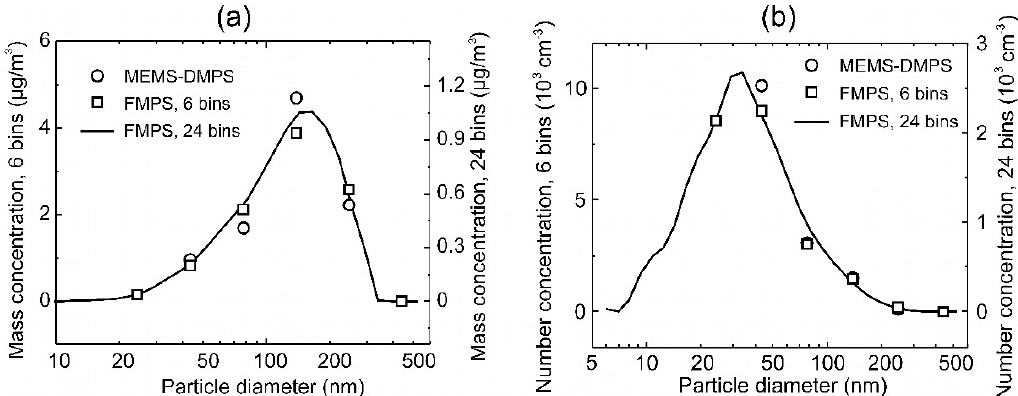
Figure 7. Size distributions of mass ( a ) and number ( b ) concentrations of a nebulized polydisperse carbon aerosol determined for the novel MEMS-DMPS vs. the values measured by FMPS.